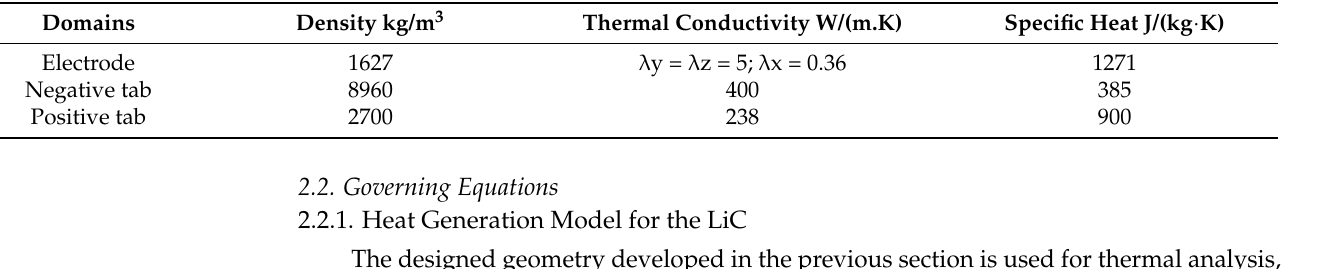
Table 2. Characteristics of different domains of the LiC